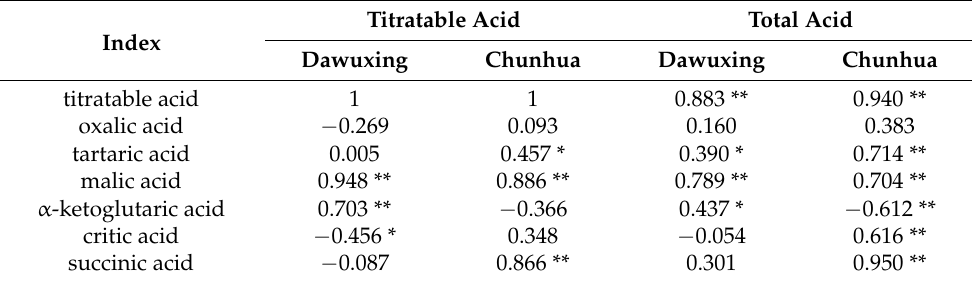
Table 2. Correlations between the titratable acid, total acid, and organic